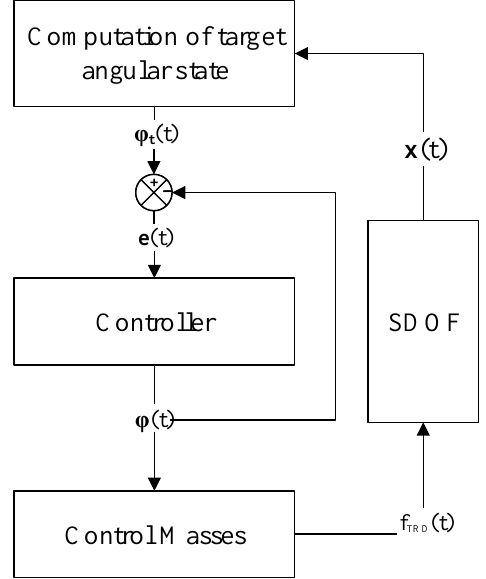
Figure 3. The TRD control for the SDOF